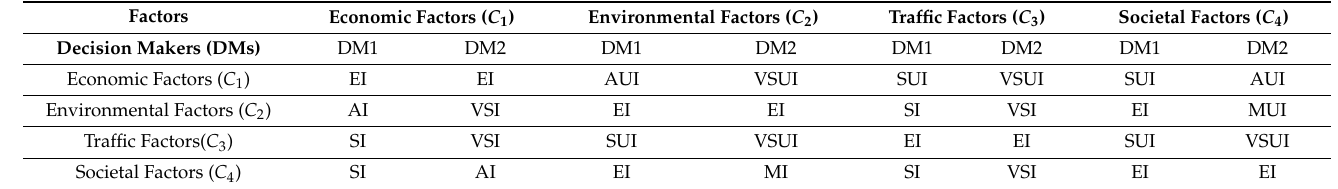
Table 5. Representation of comparison between